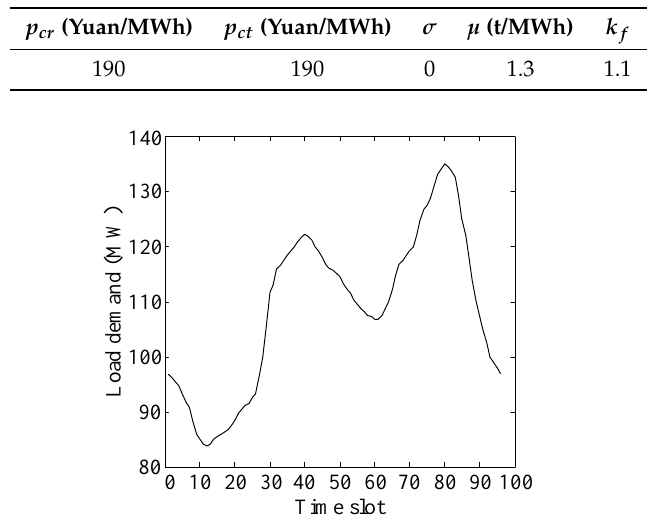
Table 3. System parameters.